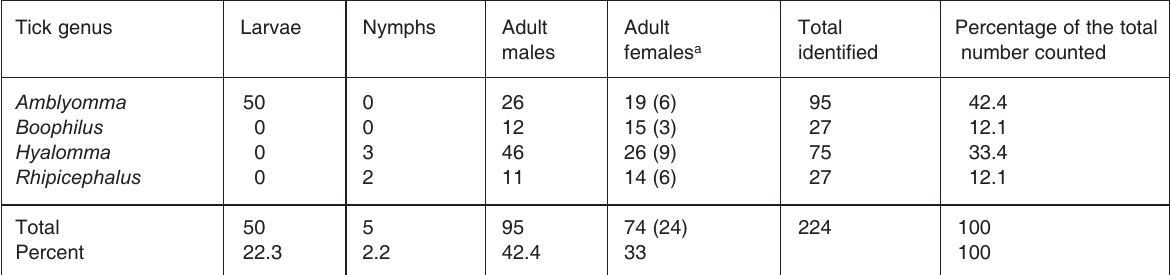
TABLE 1 The numbers and developmental stages of ticks identified and counted from goats from all the study sites Tick genus